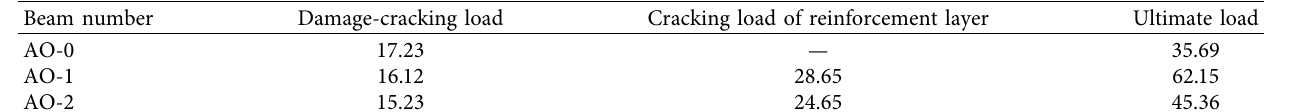
Table 2: Summary of damaged beam bearing